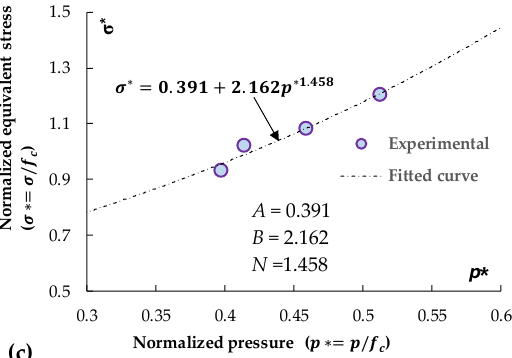
Figure 3. Relationship curve of stress–strain and the HJC parameters. ( a ) CTC deviator stress–strain curve; ( b ) Fitting curve of the CTC maximum and minimum principal stress relationship; ( c ) Fitting curve of the normalized equivalent stress and normalized pressure relationship.